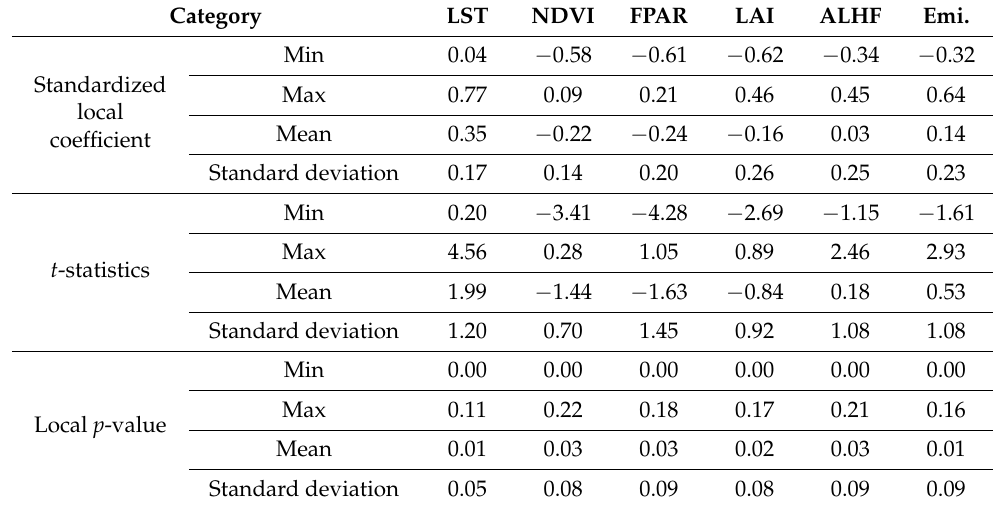
Table 4. Results of the GWR between GOSAT XCO 2 (dependent variables) and heat wave-induced photosynthetic factor, including CO 2 emissions (ODIAC-PSnet, independent variables).